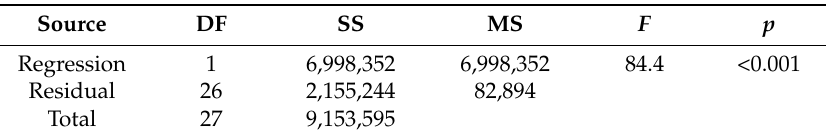
Table 2. Linear regression analysis of variance for the plot of microbial biomass carbon as a dependent variable against soil organic carbon for grassland.